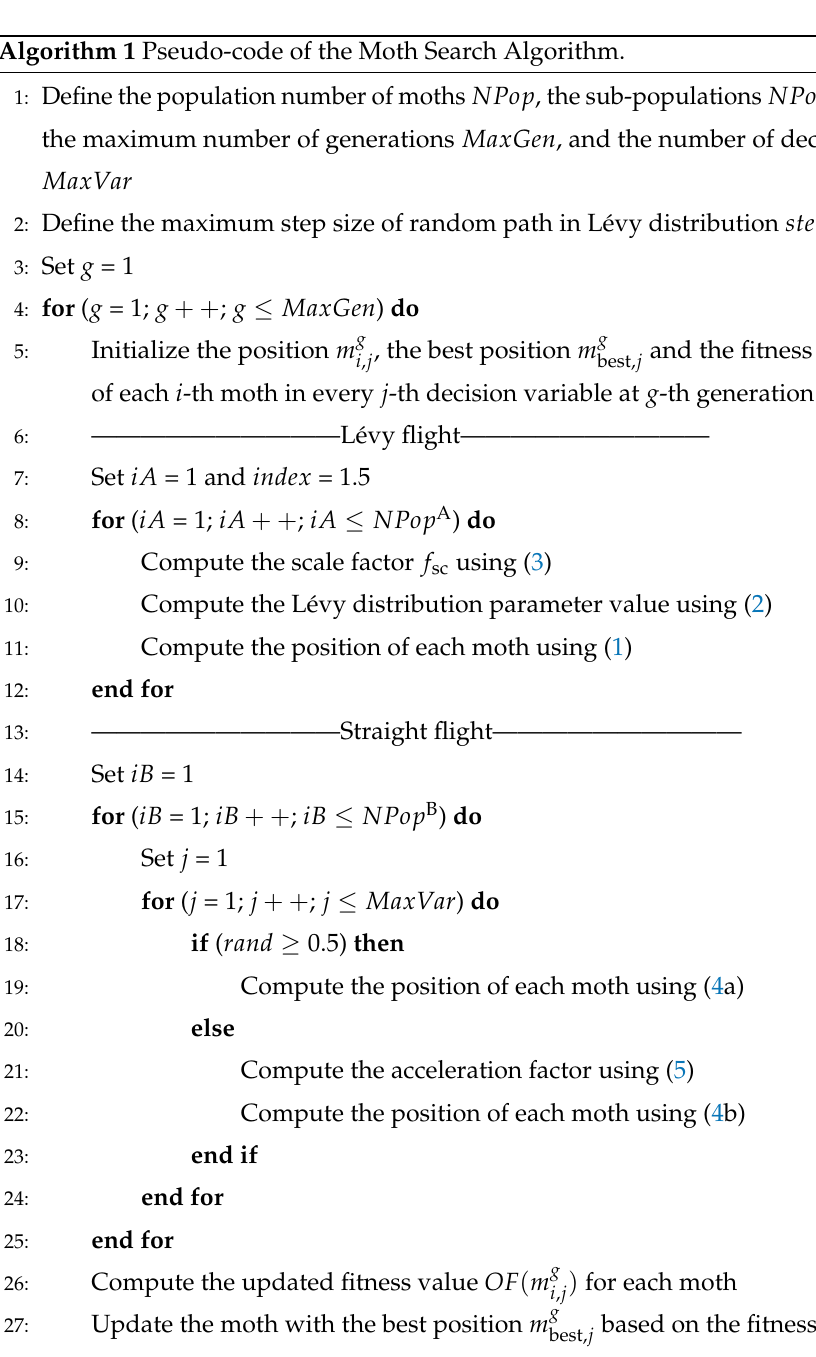
Algorithm 1 Pseudo-code of the Moth Search